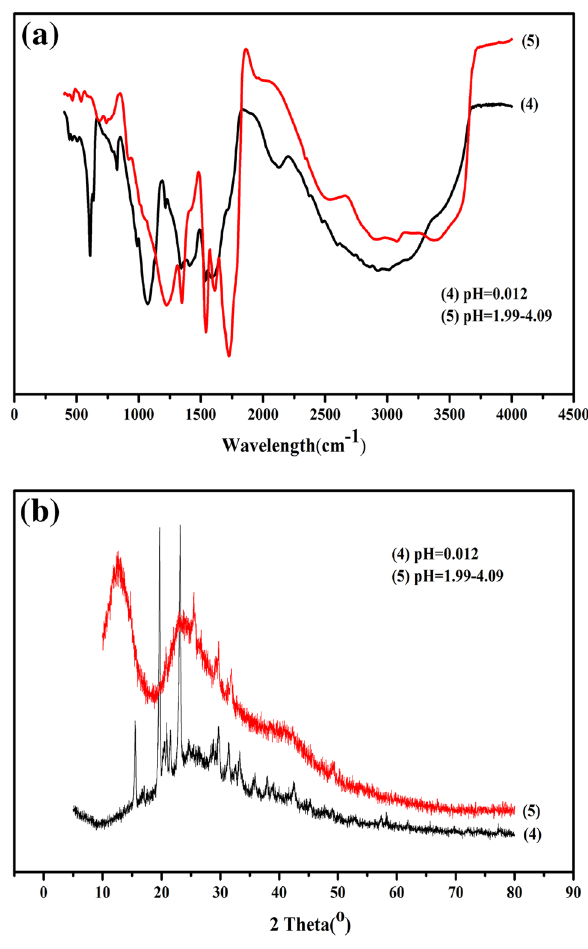
Fig. 4 The FT-IR ( a ) and XRD ( b ) spectra of depolymerization products of coal at different pH